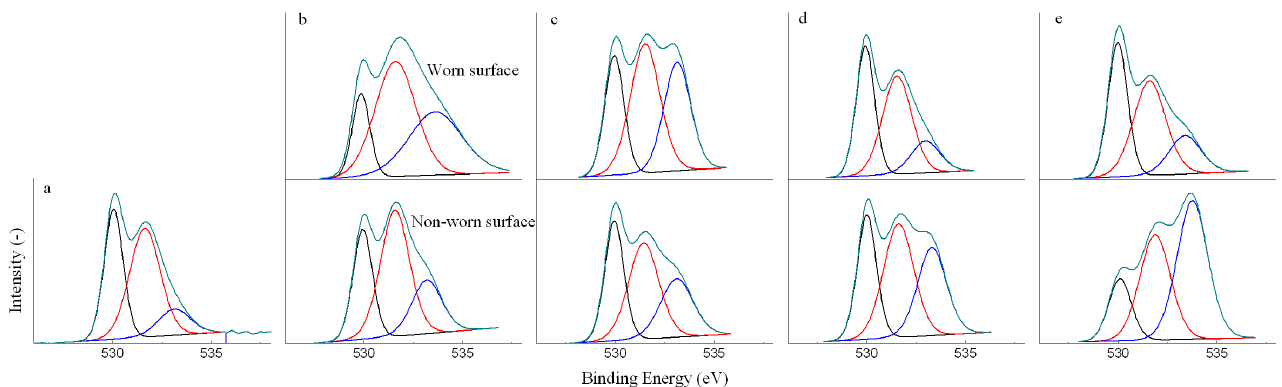
Figure 4. Deconvoluted O 1s XPS spectra of the untreated new ball ( a ) and balls lubricated with EO10 ( b ), EO30 ( c ), EO50 ( d ) and BO ( e ) under 392